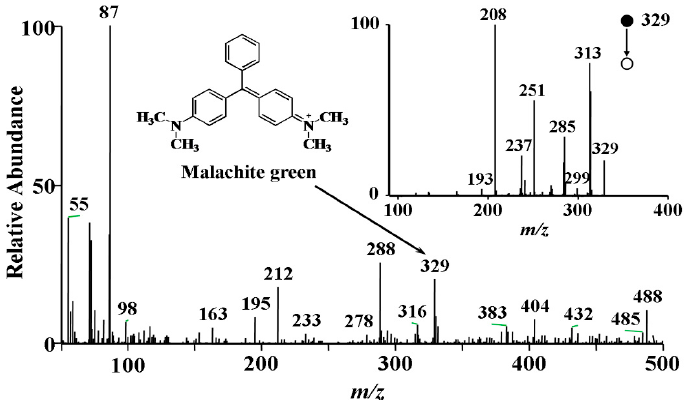
Figure 2. EESI-mass spectra of 0.1 mg · L − 1 malachite green obtained directly from water sample. The inset shows the MS/MS spectrum of malachite green ( m / z